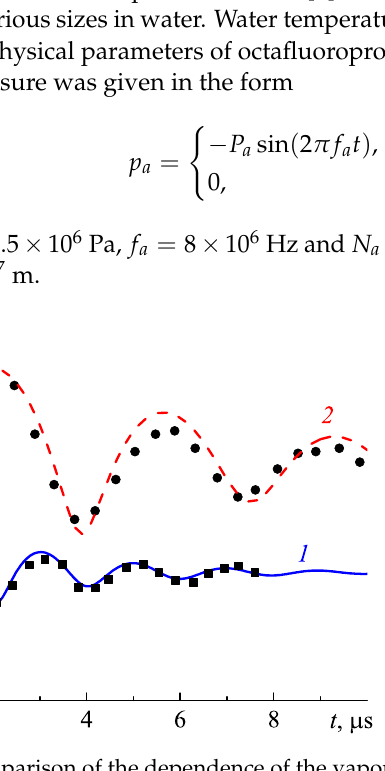
Figure 2. Comparison of the dependence of the vapor bubble radius on time with the experimental data [8] (the cross shows the moment of complete evaporation of the droplet): 1— R 20 = 10 − 6 m and 2— R 20 = 1.85 × 10 − 6 m; r s 0 = 0, ρ s = ρ l , G s = 0 and G l =